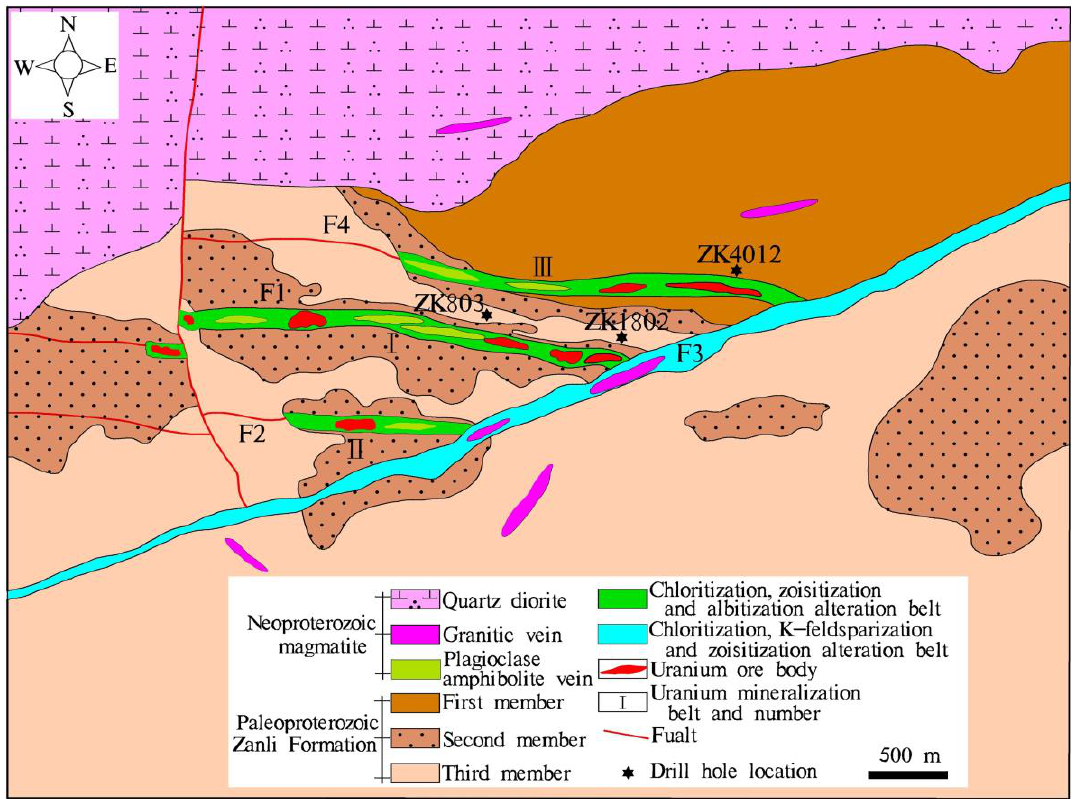
Figure 3. Schematic geologic map of the Datian uranium deposit (modified from Sun et al. [18]).